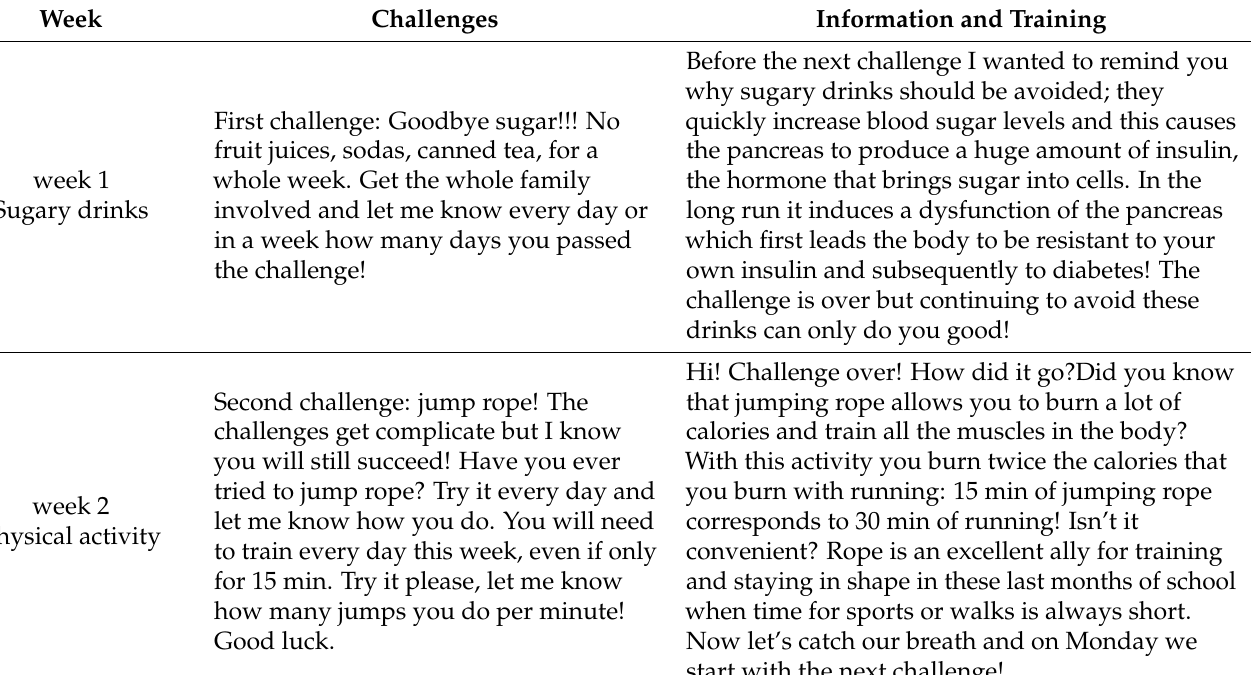
Table A3. Scheme of “Challenging messaging”. (English